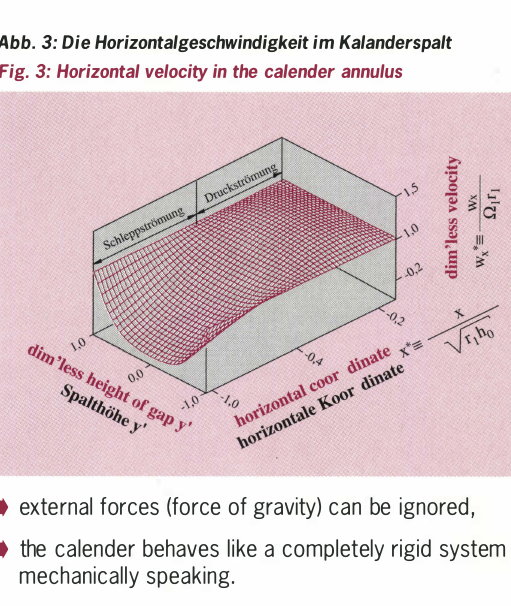
Fig. 2: Maximum pressure in the calender annulus as a function of the temperature of the rolls